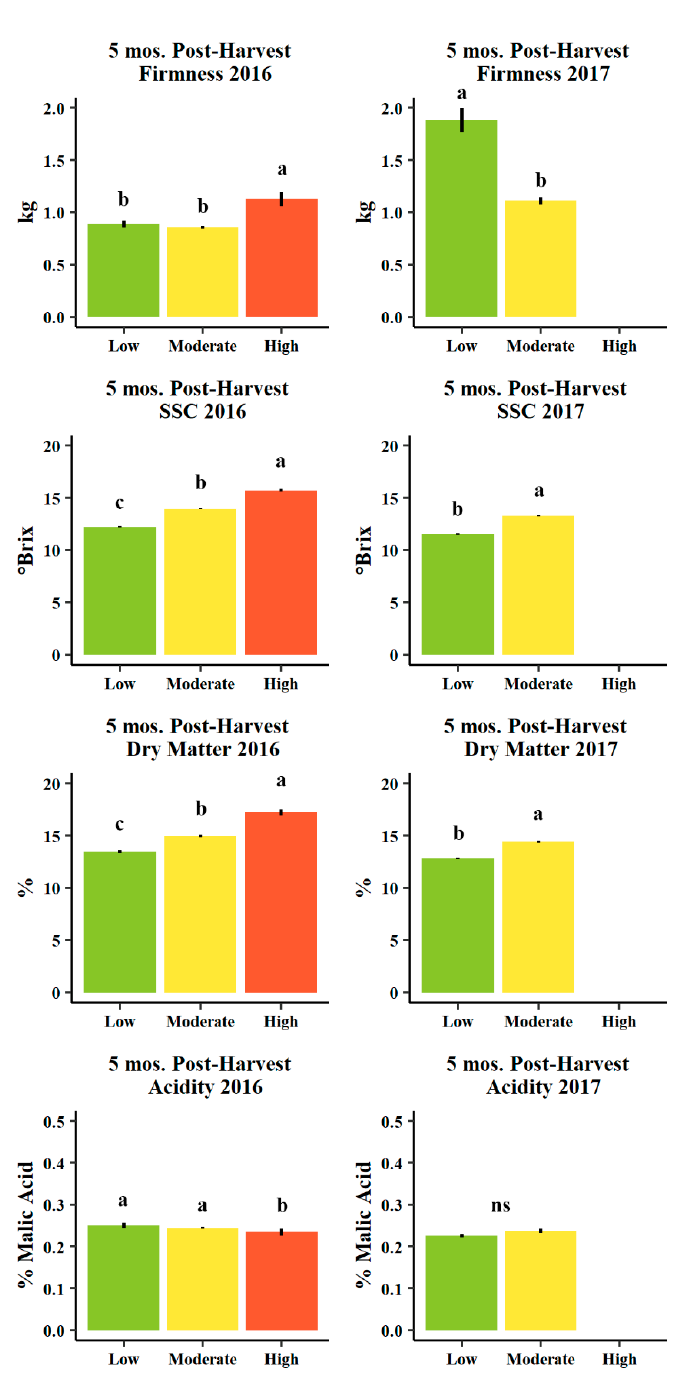
Figure 10. Mean firmness (kg, n = 457 and 253 in 2016 and 2017, respectively), soluble solids content (SSC, ◦ Brix, n = 457 and 253 in 2016 and 2017, respectively), destructively measured actual dry matter (%, n = 95 and 173 in 2016 and 2017, respectively), and acidity (% malic acid, n = 57 and 45 in 2016 and 2017, respectively) for d’Anjou fruit evaluated at five mos. post-harvest (five months after harvest in cold storage plus seven days of ripening at room temperature) in 2016 ( left ) and 2016 ( right ) among Low ( < 13%, green), Moderate (13–16%, yellow), and High ( > 16%, orange) predicted dry matter categories. Error bars indicate ± standard error. Di ff erent letters indicate significance di ff erence among means ( p < 0.05, Tukey HSD). “ns” indicates no significant di ff erence among means ( p > 0.05, Tukey